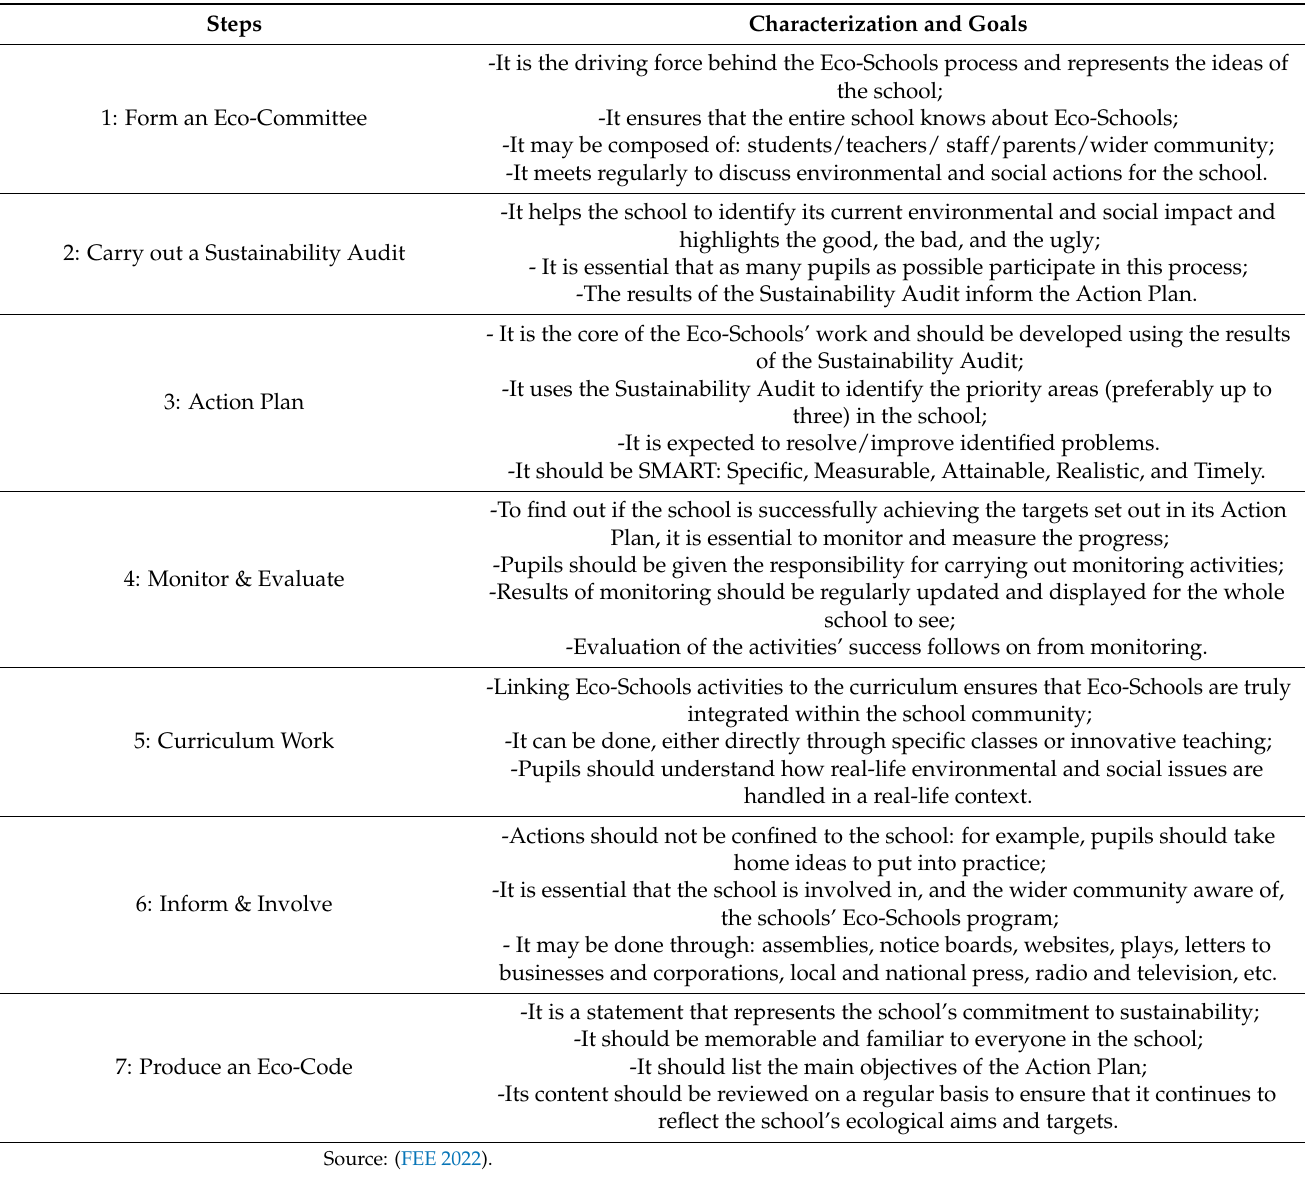
Table 1. Seven-Step Methodology on the Eco-Schools